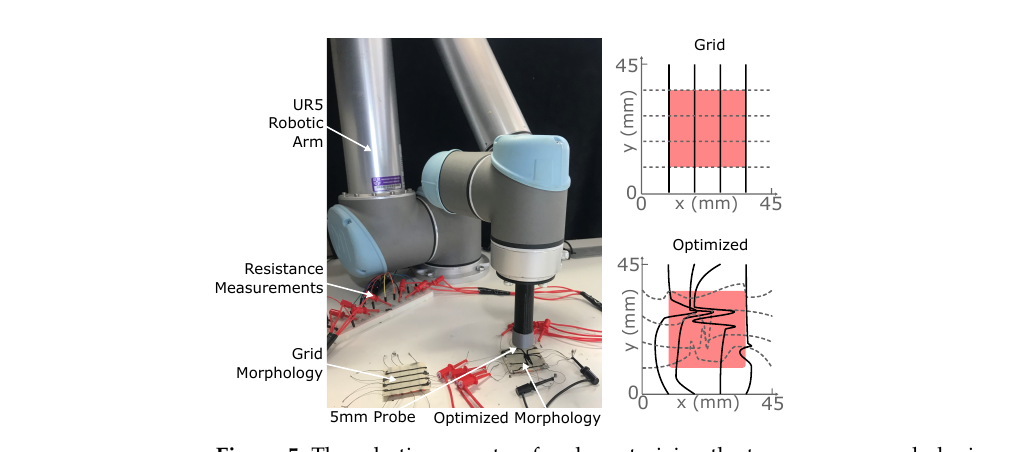
Figure 5. The robotic arm setup for characterizing the two sensor morphologies: grid and optimized. A probe with 5 mm diameter presses 2 mm vertically downwards anywhere within the red shaded area, and the corresponding changes in channel resistances and capacitance are recorded. In the schematics, solid black lines indicate sensor channels that were uppermost during testing, and dashed grey lines those on the